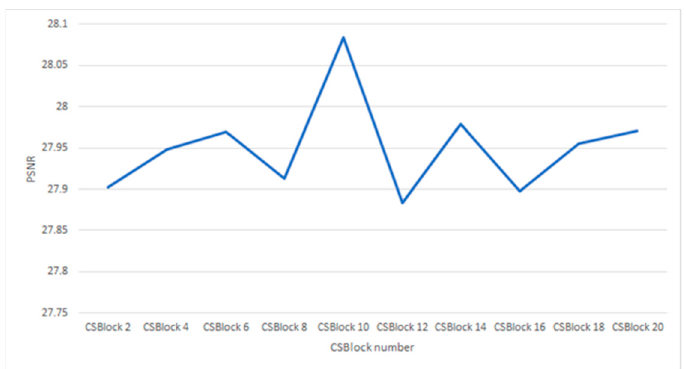
Figure 14. Results of the number of CSBlocks.